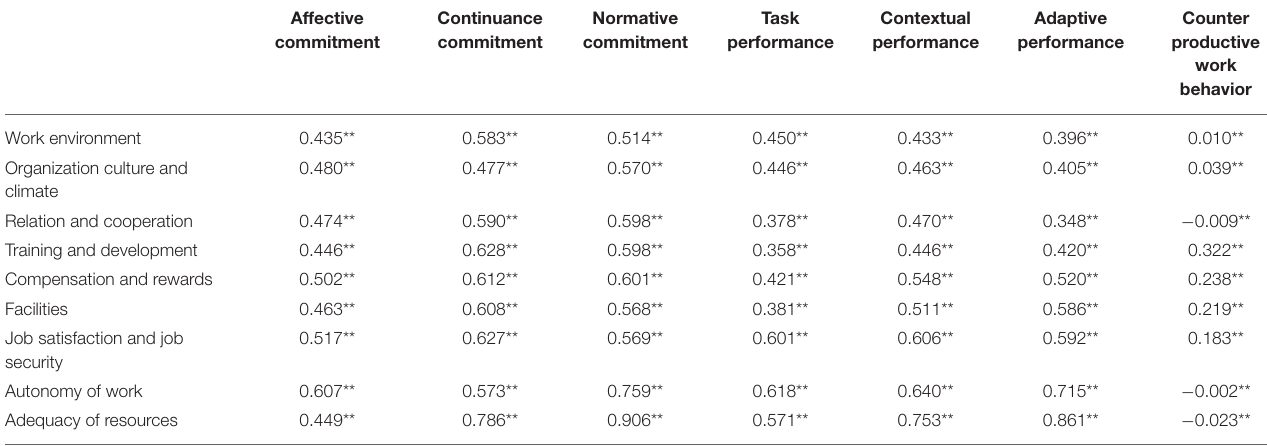
TABLE 5 | Correlations between Quality of Work Life Scale (QWLS) subscales, Organizational Commitment Questionnaire (OCQ), and Individual Work Performance Questionnaire (IWPQ) subscale using the Pearson